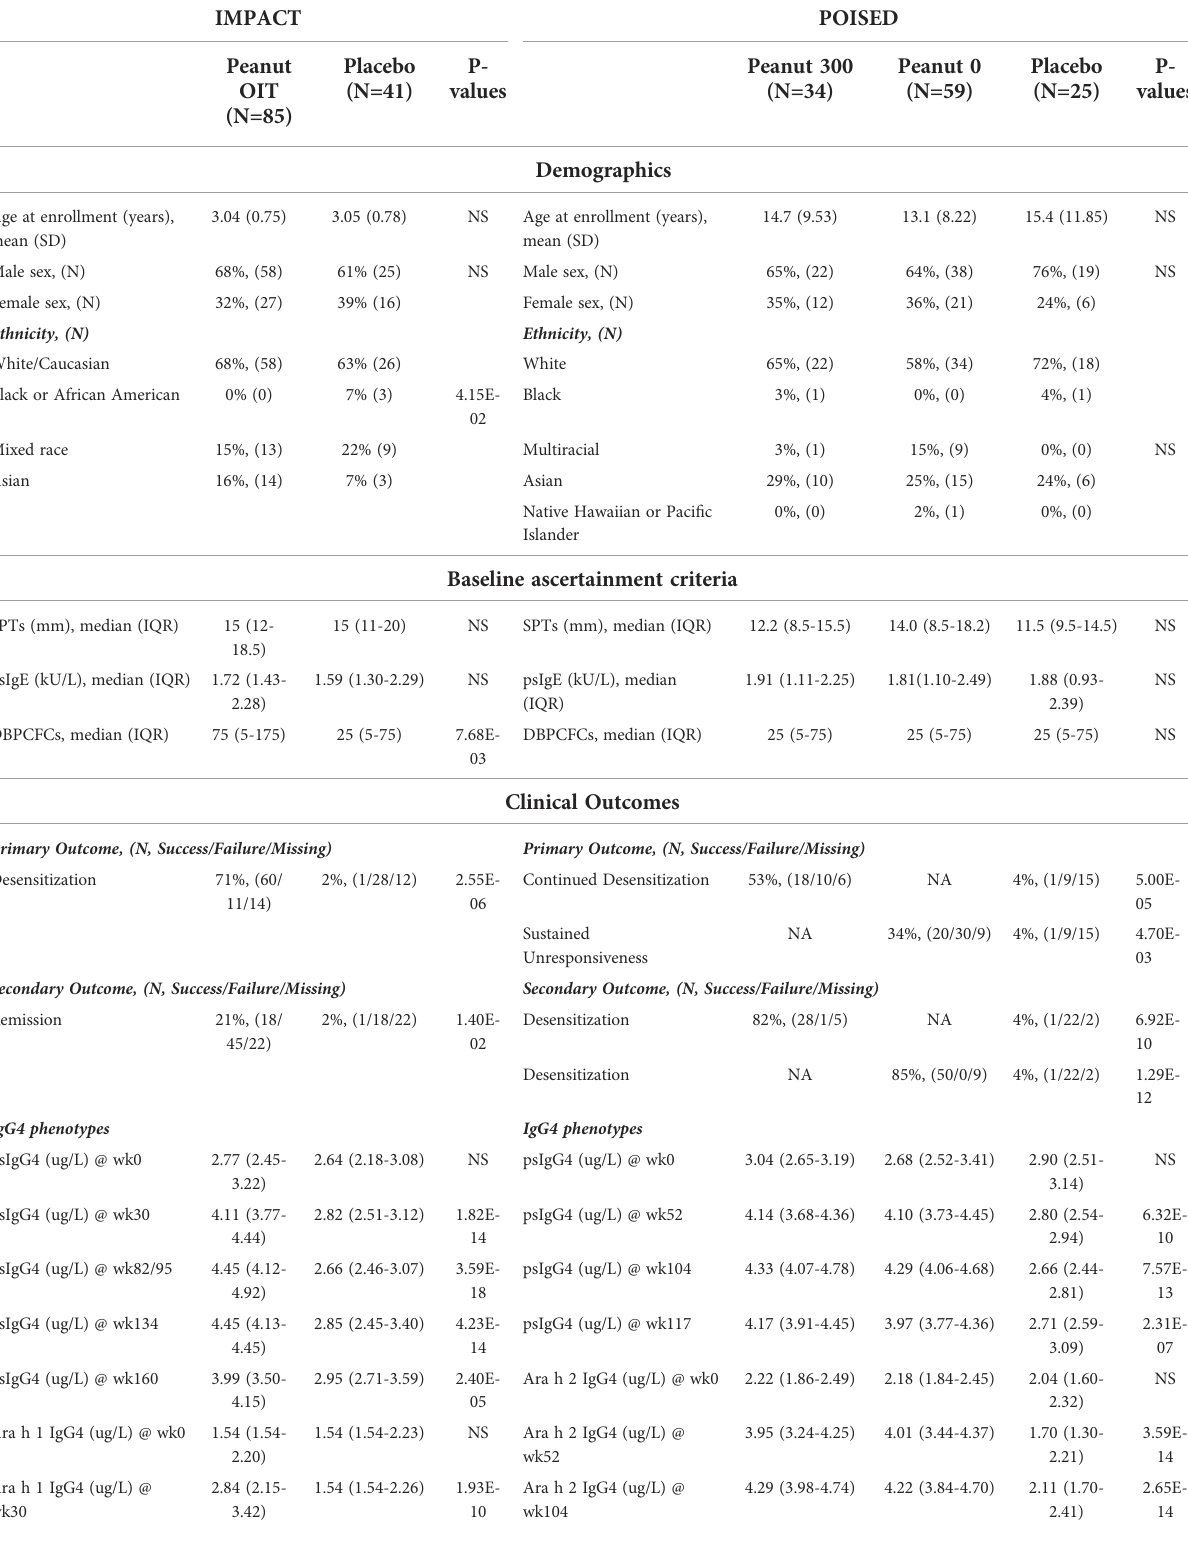
TABLE 1 Demographics, baseline ascertainment criteria, clinical outcomes, and IgG4 levels of IMPACT and POISED genetic study participants.